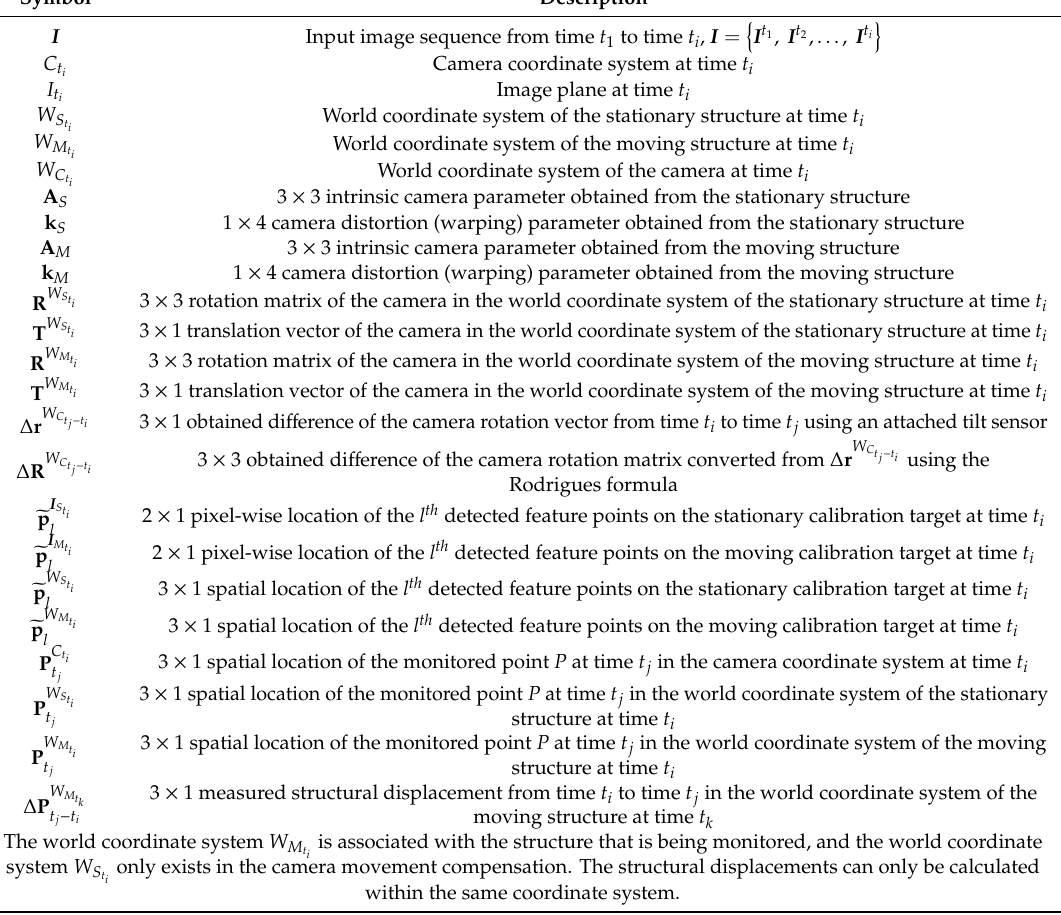
Table 1. Frequently used notations in the proposed HIVBDM